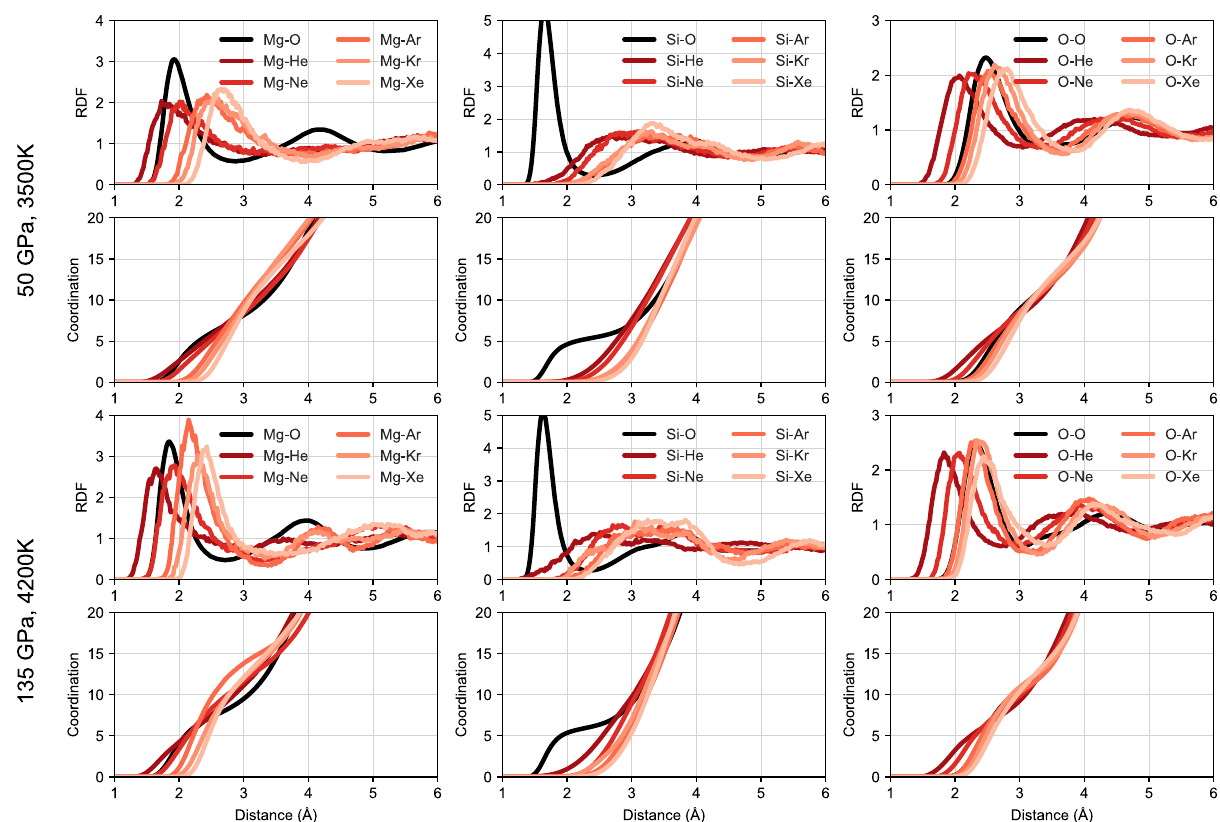
Fig. 3 Radial distribution function and coordination numbers. Results for silicate melts containing noble gases at 50 GPa, 3500 K and 135 GPa, 4200 K. For better comparison, the coordination numbers of noble gases with Mg, Si or O are scaled by the number of O atoms to the number of noble gas